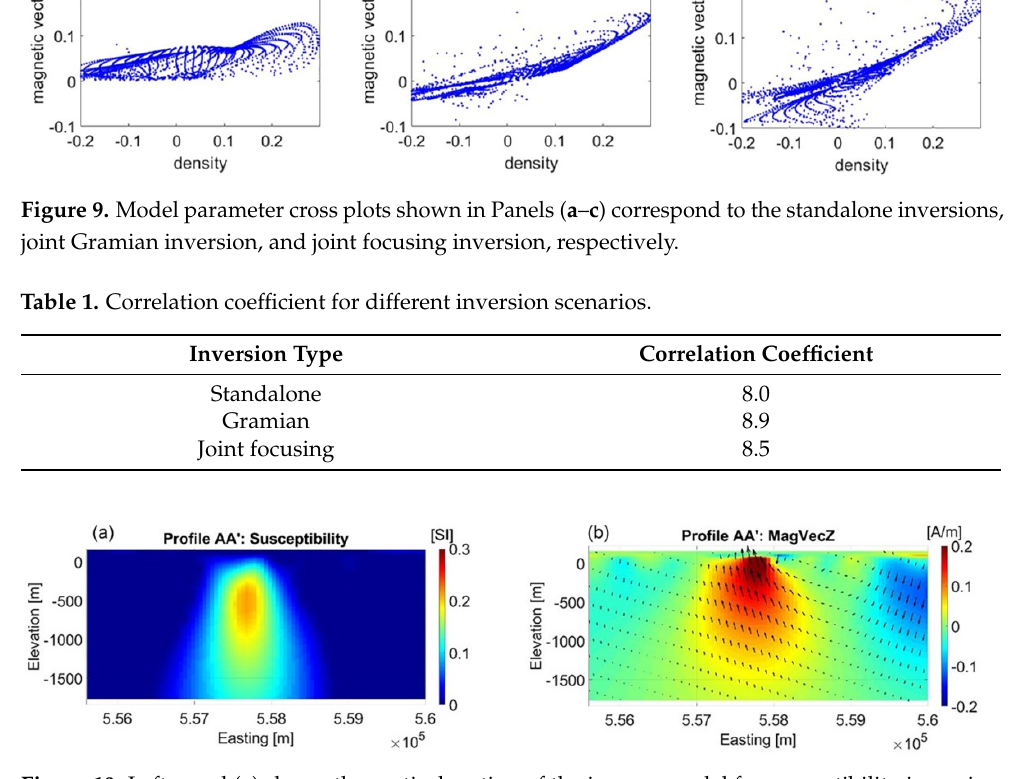
Figure 10. Left panel ( a ) shows the vertical section of the inverse model for susceptibility inversion. Right panel ( b ) shows a vertical section of the inverse model for magnetization vector inversion. The small black arrows in the right panel represent the magnetization vectors, while the color bar reflects the vertical component of magnetization.